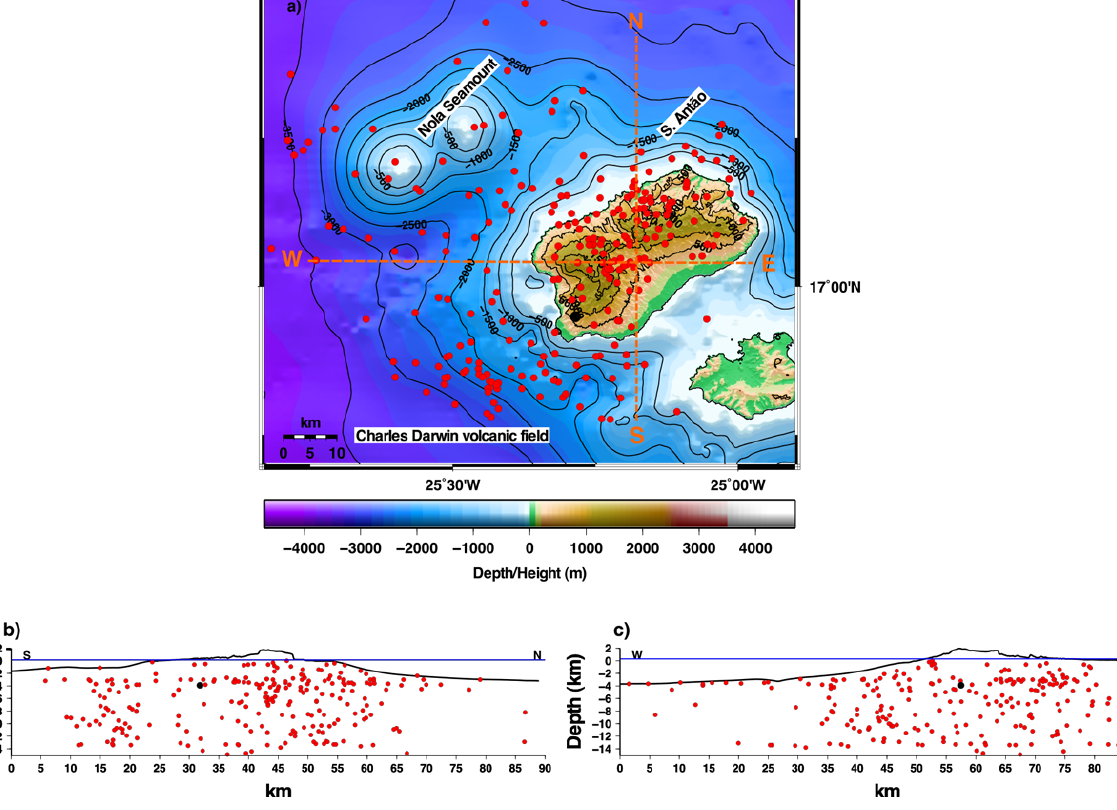
Fig. 12. Epicentral geographic distribution (red dots) of the seismic events recorded in or near S. Antão between August 2010 and May 2013, and the bathymetry (contour interval 100m). (b) Hypocentres projected on a section parallel to the S–N direction. (c) Hypocentres projected on a section parallel to the W–E direction. The black dot represents the location (on the SW rift zone) of the first event recorded during the seismic swarm (Fig. 14) that occurred on 13 December